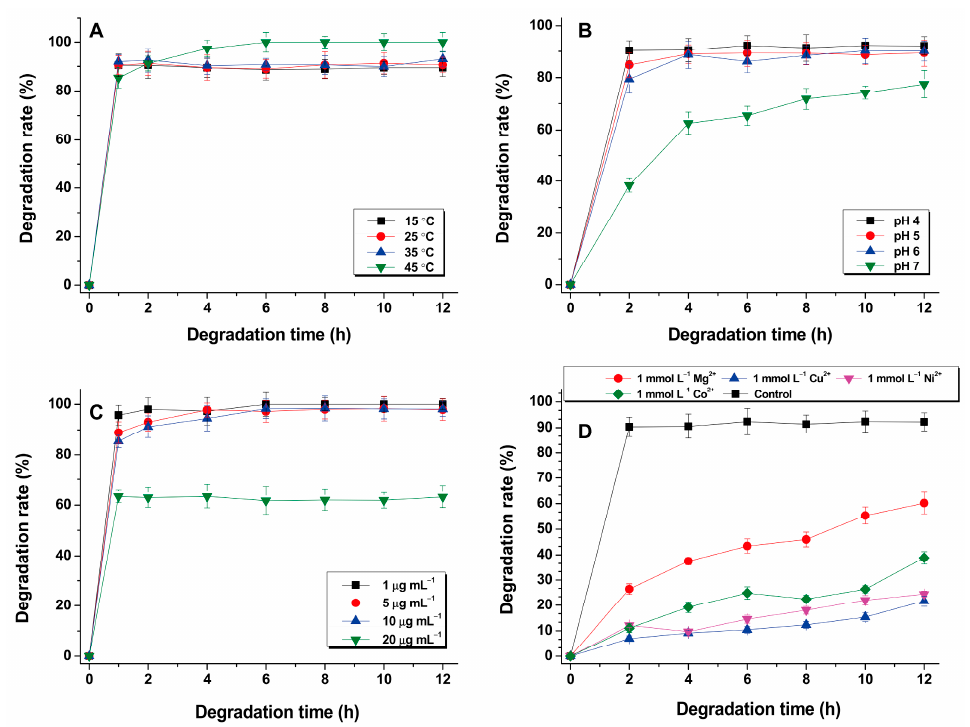
Figure 6. Effects of different temperatures ( A ), pH values ( B ), initial CIP concentrations ( C ) and metal ions ( D ) on CIP degradation by the BMO composites.